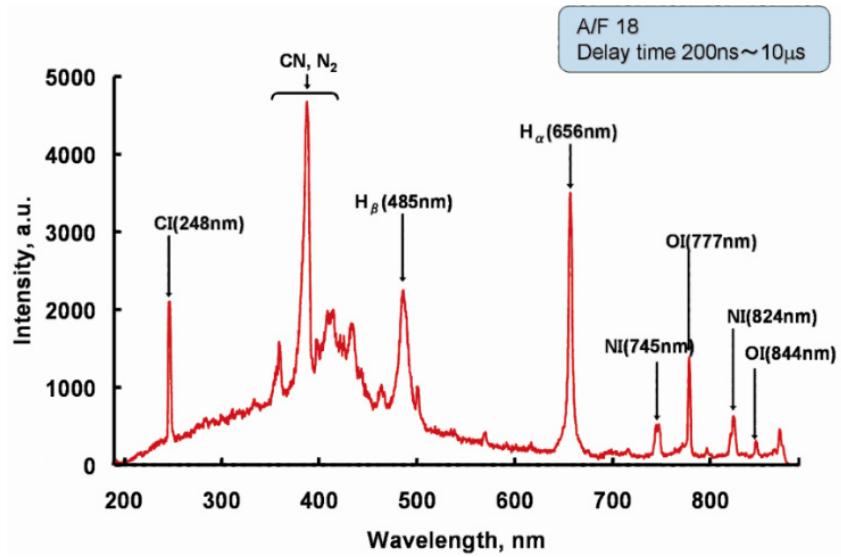
Figure 11. LIBS spectrum (A/F = 18). At a delay time of 200 ns to 10 μ s, the ionic spectra are ob- served which are then used in cyclic measurements of A/F.